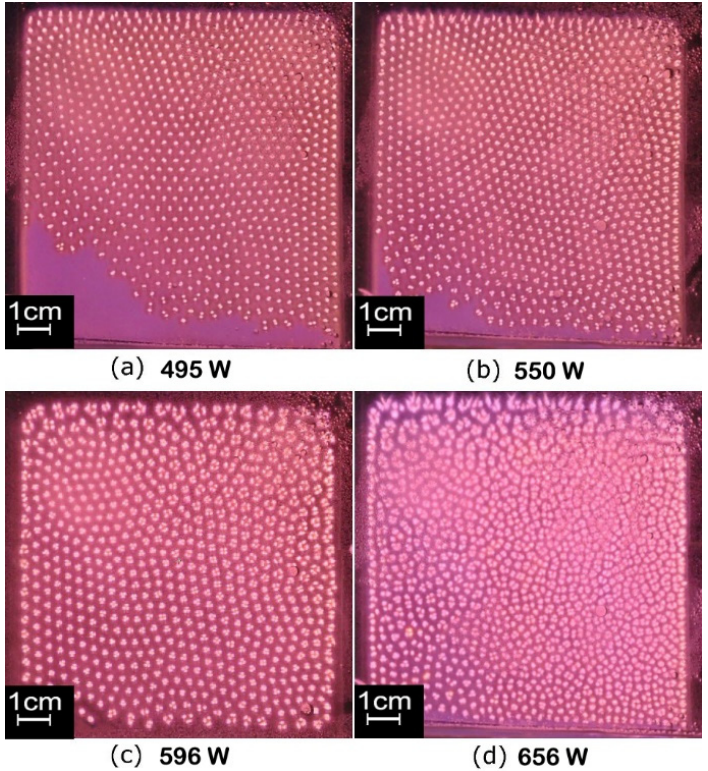
Figure 4. Effect of discharge power on self-organizing form of plasma, N 2 = 50 mL/min, gas mixture = 2 L/min (N 2 = 2.5 %). ( a – d ) correspond to points 9–12 in Figure 2 and photos 9–12 in Figure 3. Exposure time: 1 ms.